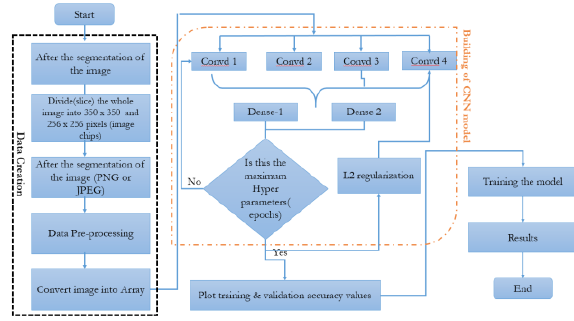
Figure 18 . Flow chart of CNN.